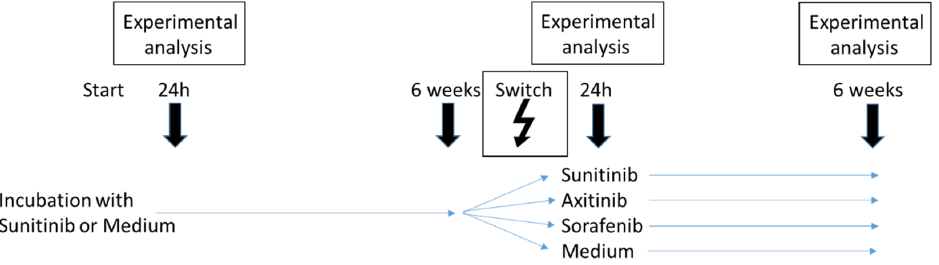
Figure 1. Schematic illustration of the study